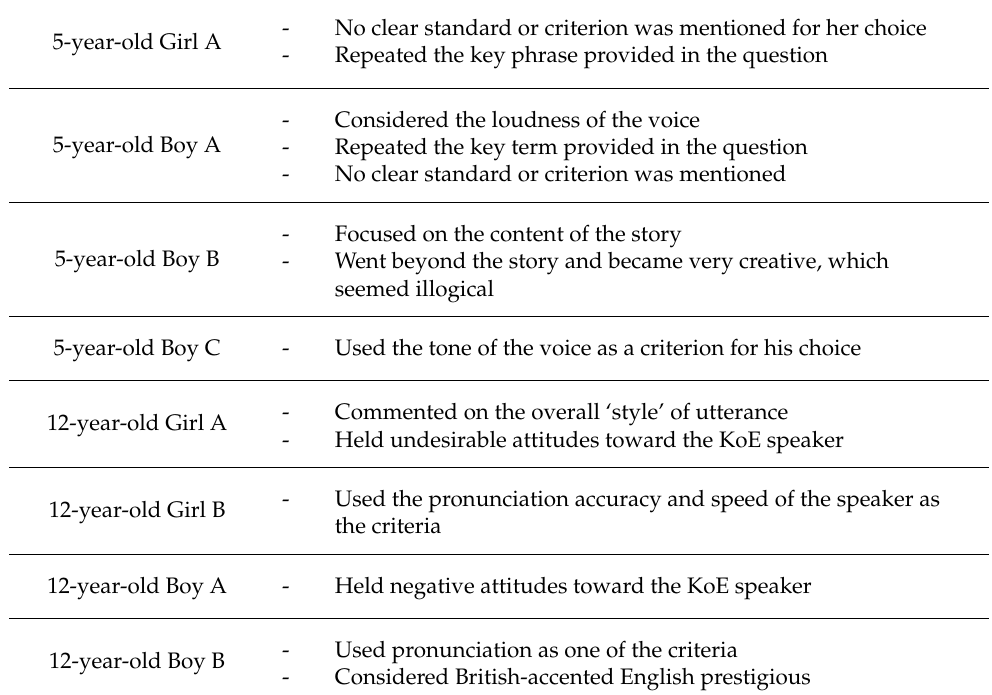
Table 5. Summary of children’s response patterns for the follow-up question: Why do you think